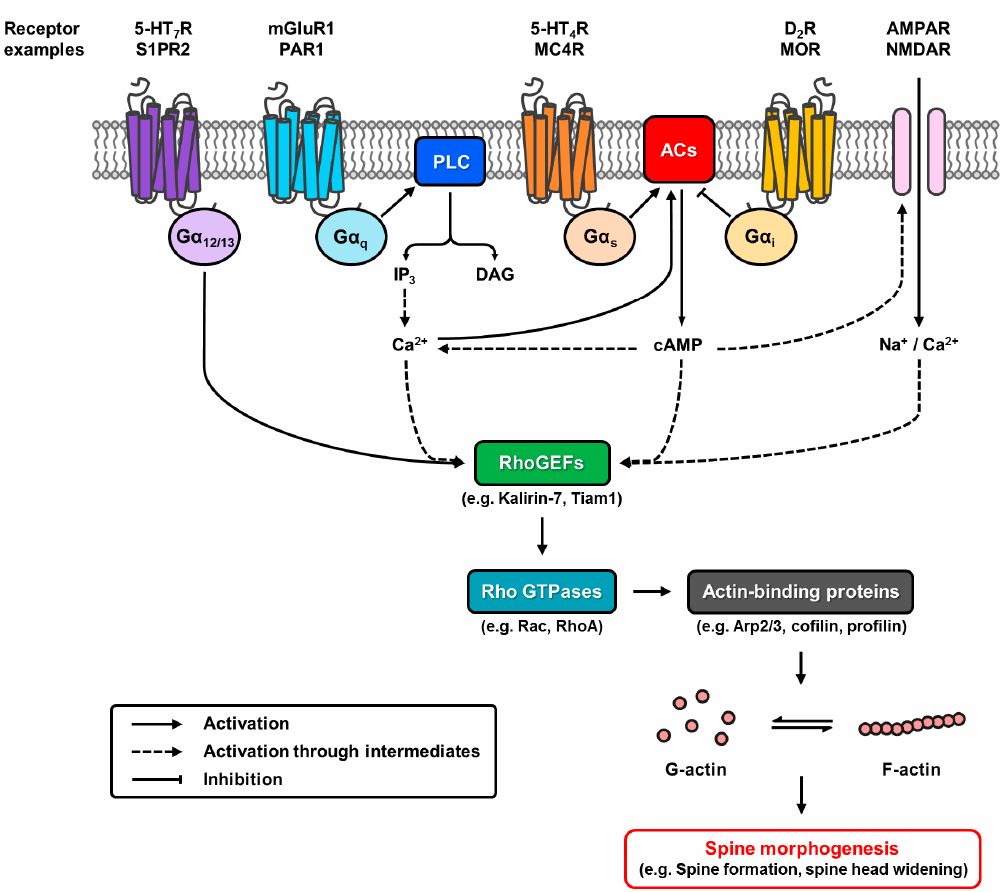
Figure 2. Putative pathways of G protein-coupled receptor (GPCR) modulation of structural plasticity. Dynamic reorganisation of the actin cytoskeleton controlled by actin-binding proteins underlies spine morphogenesis. GPCRs modulate this event by regulating Rho GTPase activity through Rho guanine nucleotide exchange factors (RhoGEFs). G 12/13 -coupled receptors directly interact with RhoGEFs, whereas G q - and G s/i -coupled receptors alter the activation state of RhoGEFs via the second messengers Ca 2+ or cyclic adenosine monophosphate (cAMP). Crosstalk potential exists as G protein signalling pathways overlap. GPCRs can also modify the Ca 2+ permeability of glutamatergic ion channels to modulate the process.